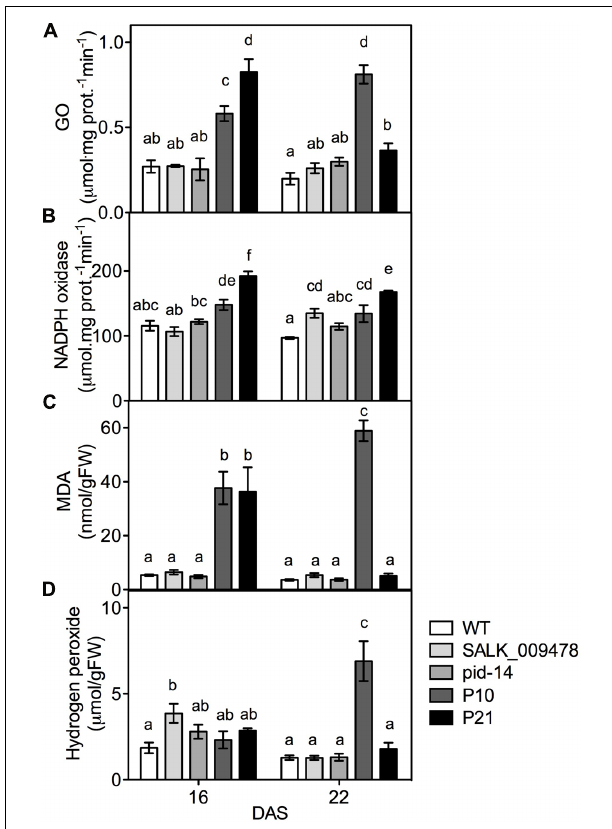
FIGURE 4 | Quantification of oxidative stress indicators in rosettes of WT and lines with altered PID expression. Glycolate oxidase; GO activity (A) , NADPH oxidase activity (B) , malondialdehyde; MDA (C) , and hydrogen peroxide abundance (D) in the rosettes of WT, pid knockouts and PID OE lines at 16 and 22 DAS. Different letters in the graphs (a–f) represent significant differences between genotypes and time (Duncan test; P < 0.05; n = 3; Error bars: ±